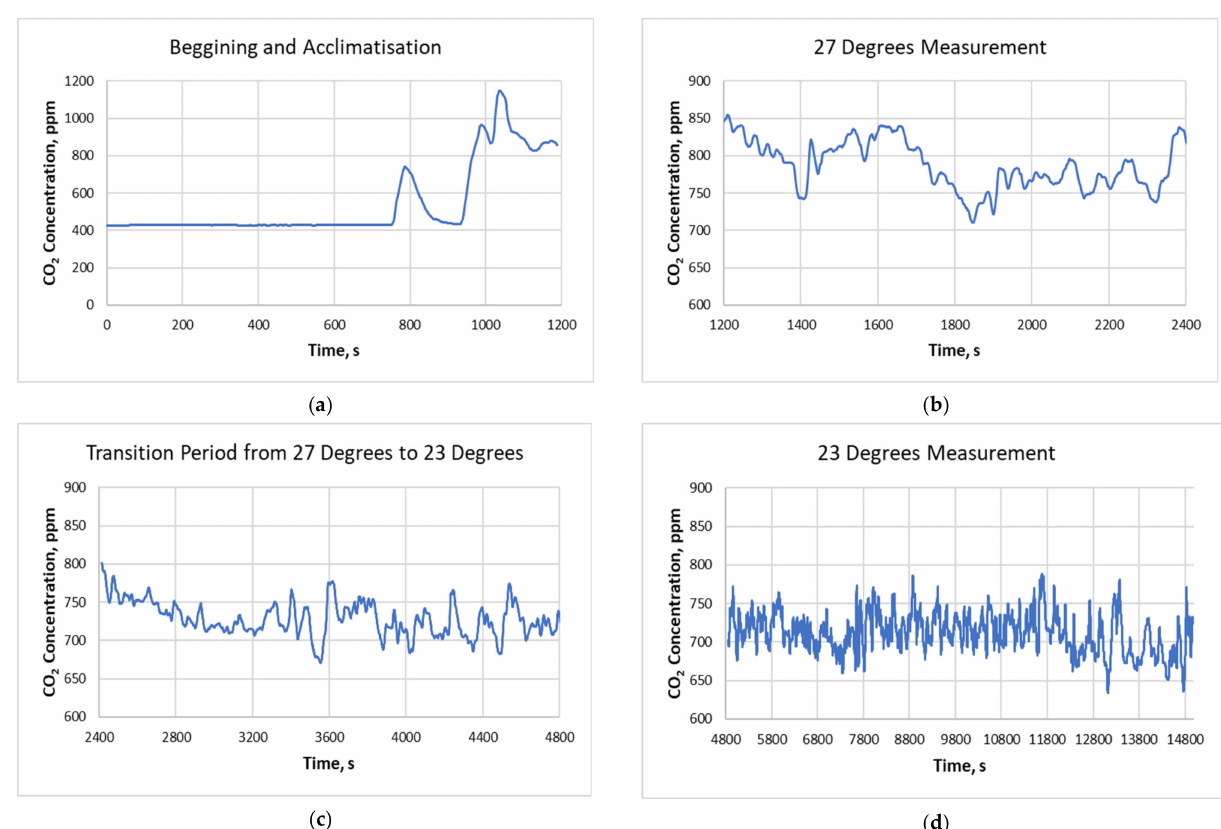
Figure 17. Carbon dioxide measurement in the climate chamber: ( a ) Beginning and acclimatization of the subject; ( b ) Expo- sure at 27 ◦ C; ( c ) Transition period from 27 ◦ C to 23 ◦ C; ( d ) Exposure at 23 ◦ C.